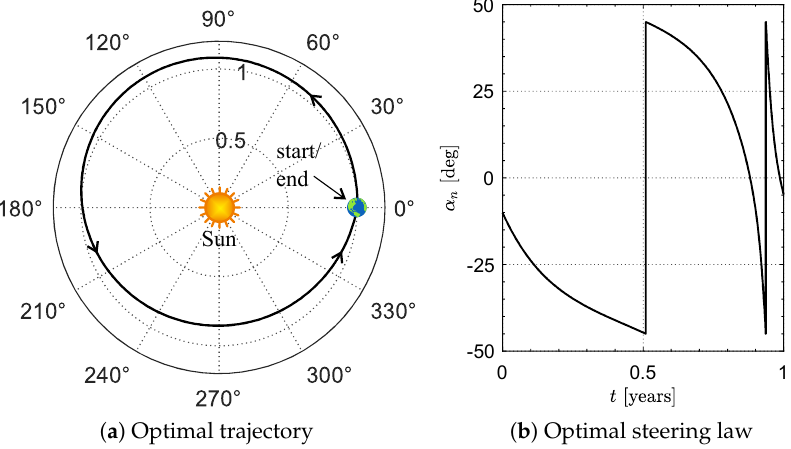
Figure 5. ∆ V -EGA maneuver trajectory and corresponding optimal steering law α n = α (cid:63) n ( t ) for = 1km/s, and t = 1year. a c = 0.5mm/s 2 , V ∞ f 0